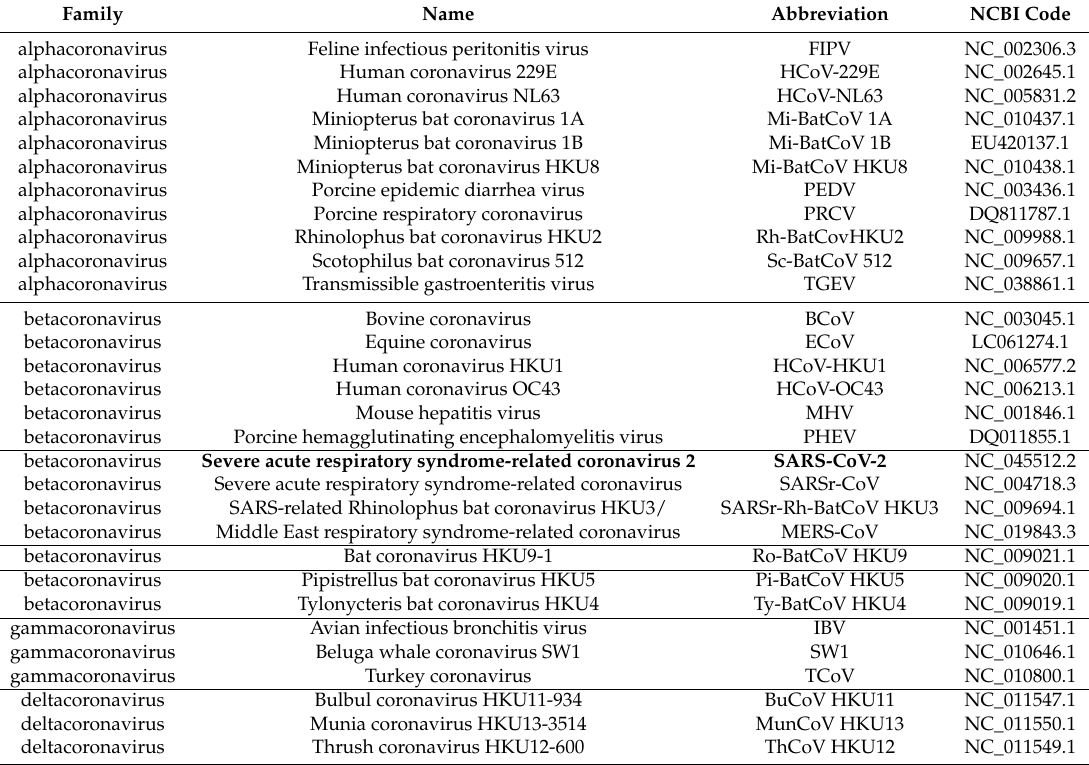
Table 1. Coronaviruses under study. Name, abbreviation, NCBI genome accession code and size (in bp) for each virus are reported.